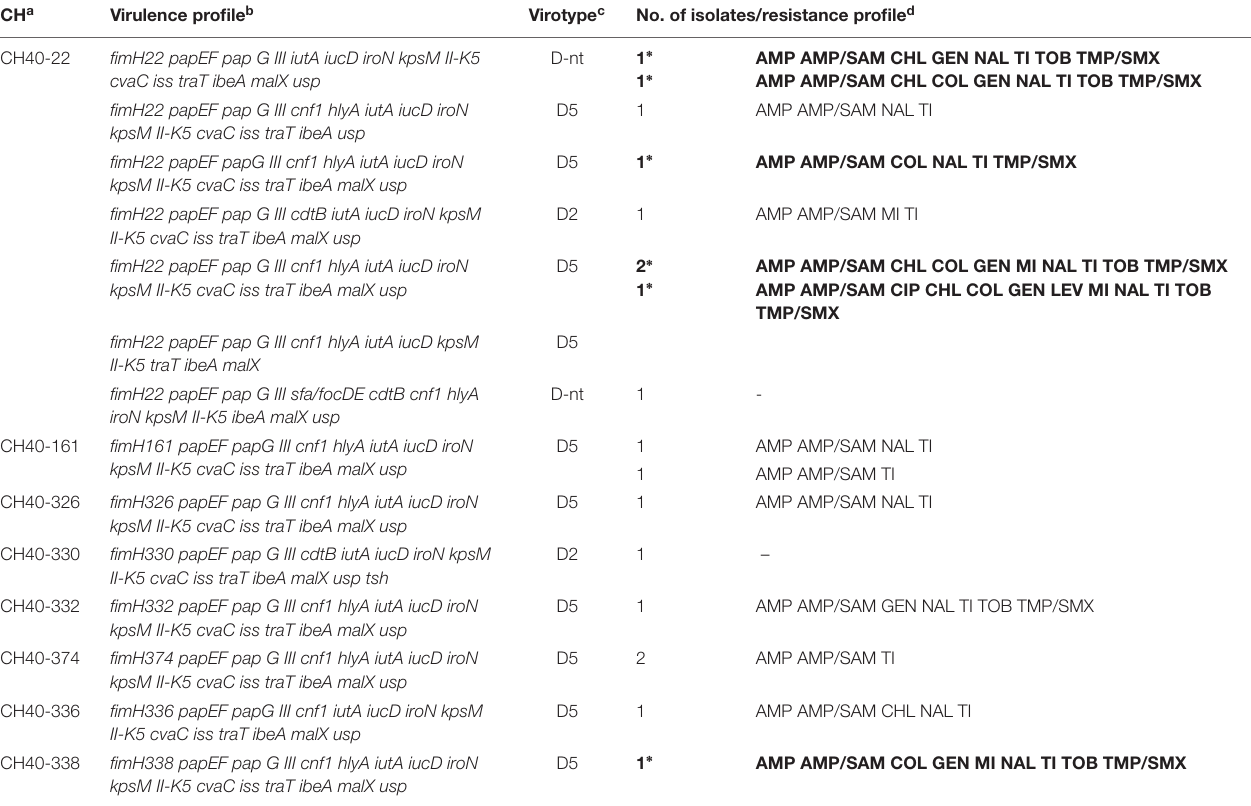
TABLE 5 | Phenotypic and genotypic characterization of the 18 O25b:H4-B2-ST131 isolates recovered from the 464 fecal samples of pigs with diarrhea. CH a Virulence profile b Virotype c No. of isolates/resistance profile d CH40-22